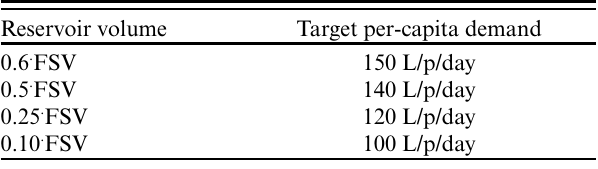
Table 2 . Drought response triggers for the Wivenhoe Dam (Seqwater 2017). Note: FSV = full supply